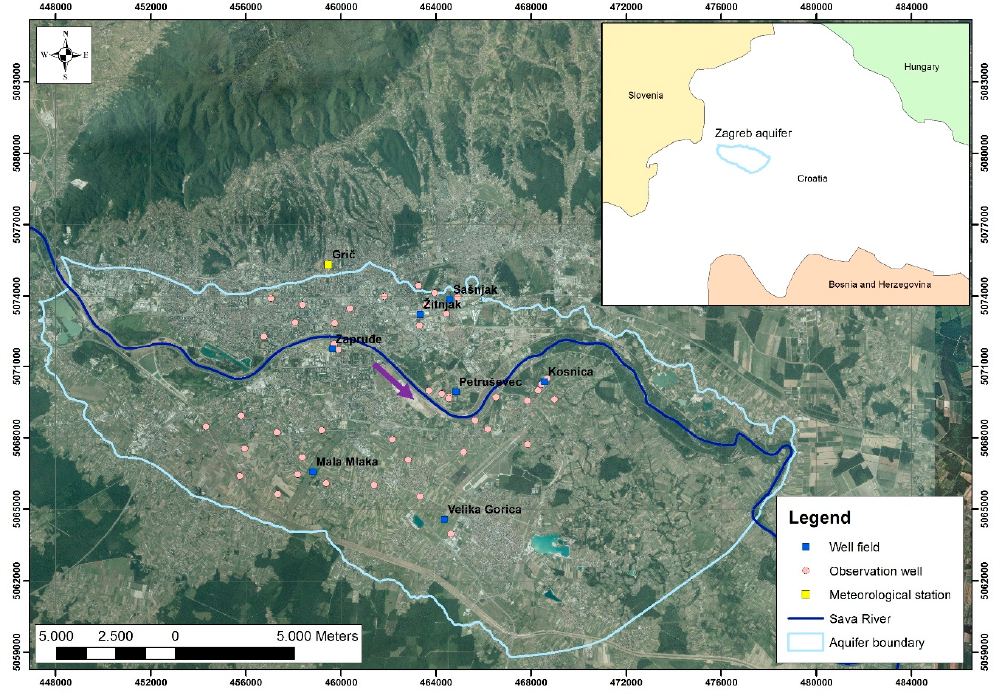
Figure 1. The location of the Zagreb aquifer system.